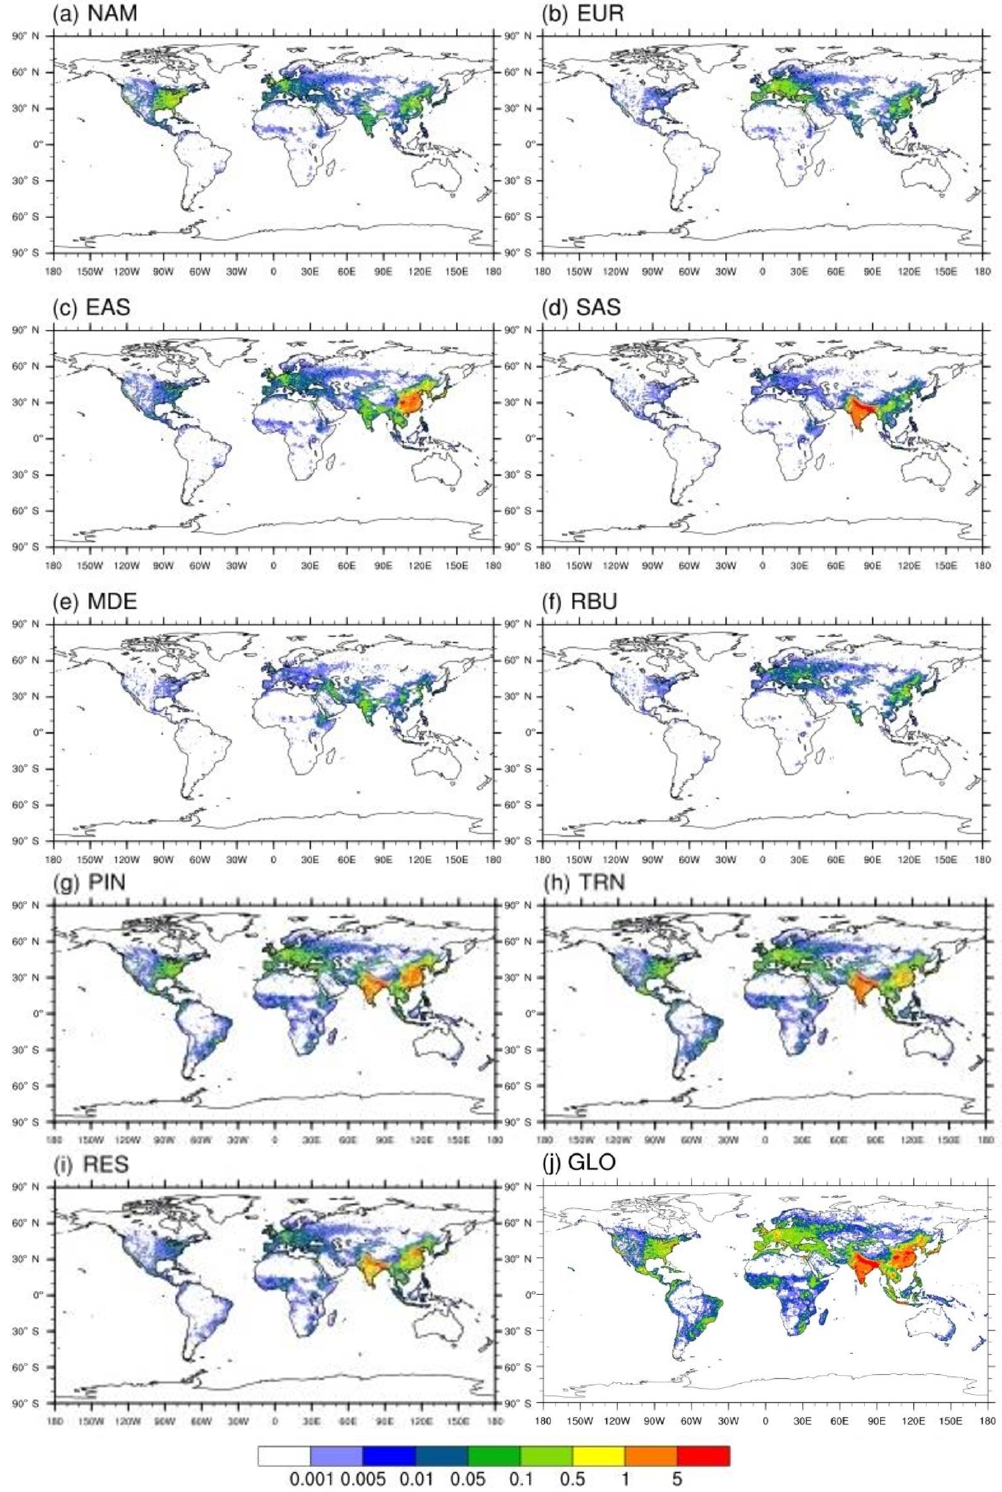
Figure 3. Annual avoided O 3 -related premature deaths in 2010 per 1000km 2 due to 20% emission reduction scenarios relative to the base case in (a) North America (NAM), (b) Europe (EUR), (c) East Asia (EAS), (d) South Asia (SAS), (e) the Middle East (MDE), and (f) Russia–Belarus–Ukraine (RBU), the (g) power and industry (PIN), (h) transportation (TRN), and (i) residential (RES) sectors, and (j) globally